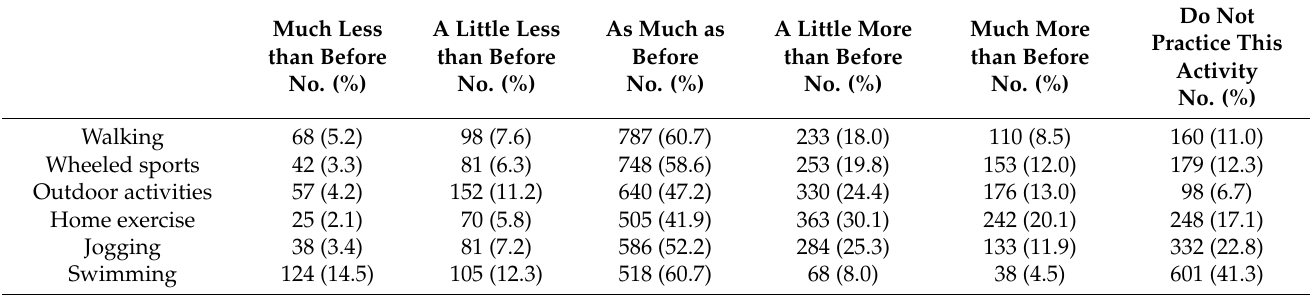
Table 4. Comparisons between physical activity practices before and during the global